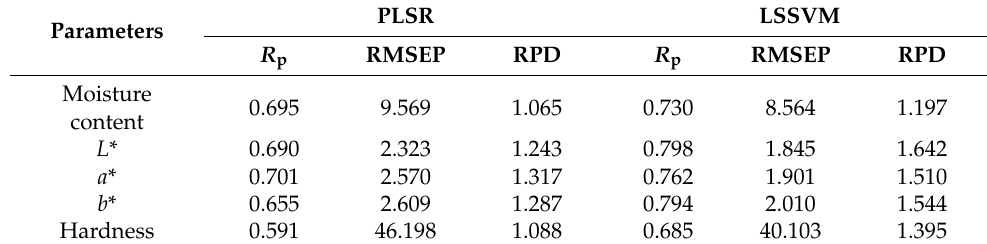
Table 5. Results of PLSR and LSSVM models based on image information.